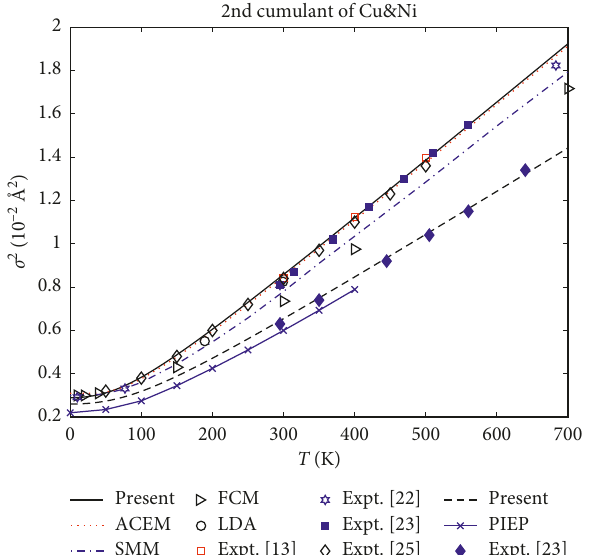
T of Figure 6: Temperature dependence of cumulant ratio σ ( 1 ) σ 2 / σ ( 3 ) of ( ) Cu and Ni calculated using the present theory, where the result for Cu is compared to the experimental values at 300K, 400K, and 500K